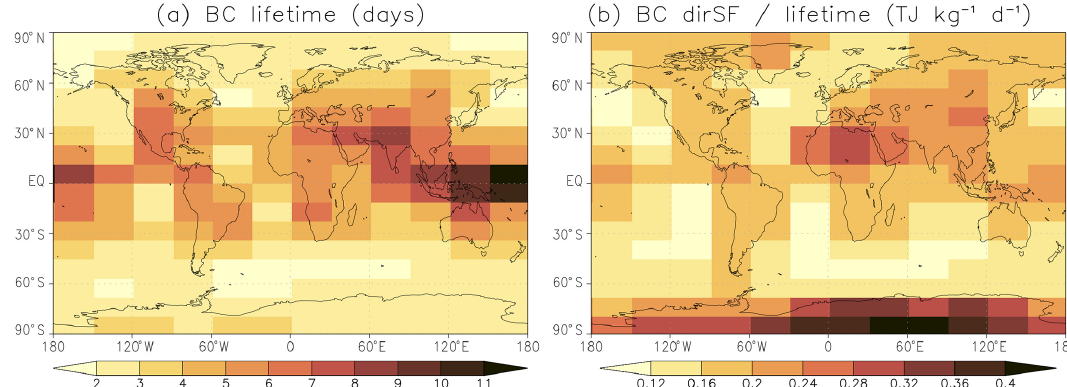
Figure 5. (a) BC lifetime (d) and (b) global mean BC direct specific forcing divided by lifetime (TJkg − 1 d − 1 ) for the experiments in which uniform BC emissions over the year were assumed separately for emissions in the 192 lat–long